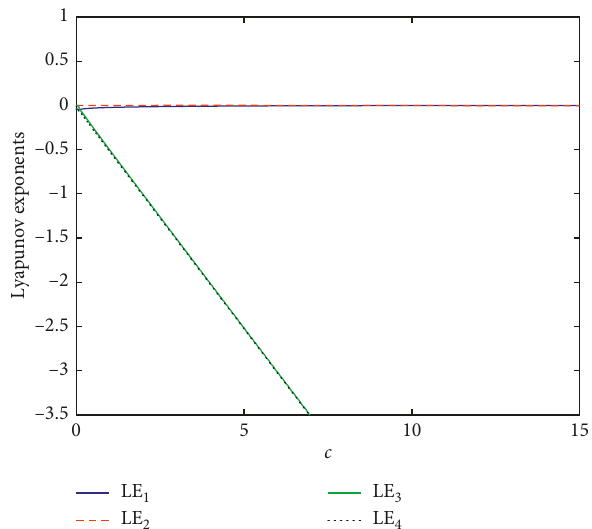
18 and (b) a 23. (cid:31) (cid:31)